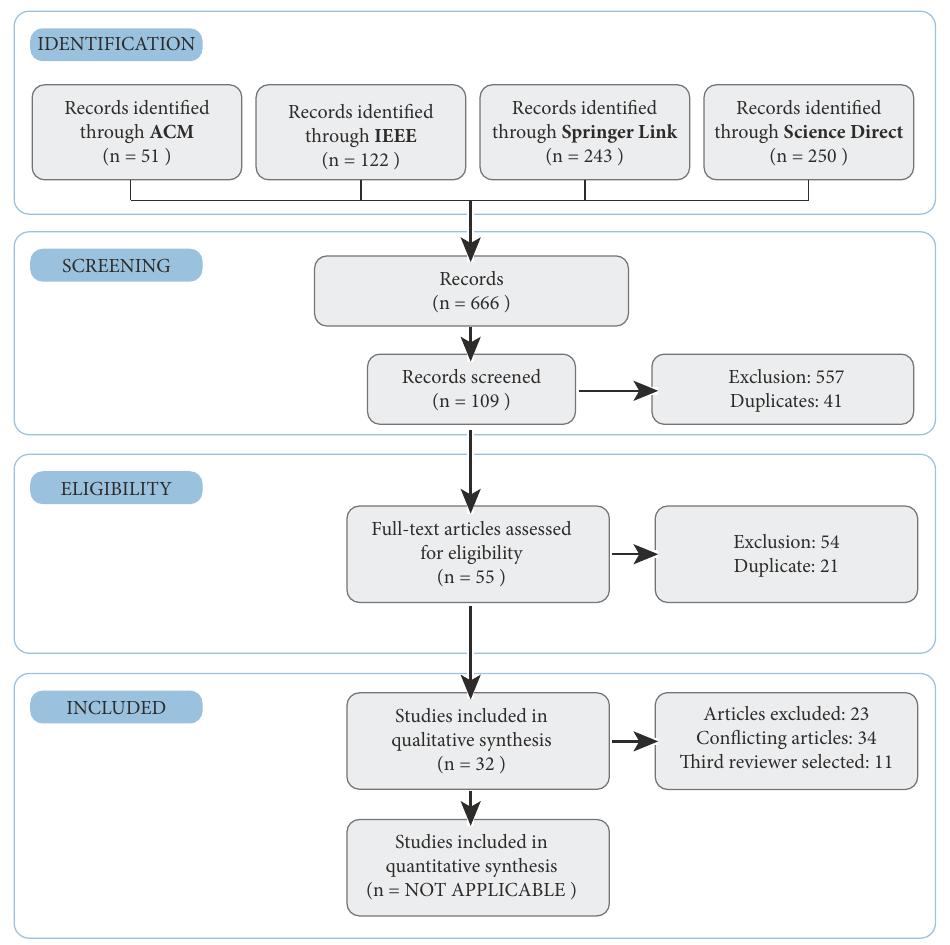
Figure 1: Flow diagram of the study